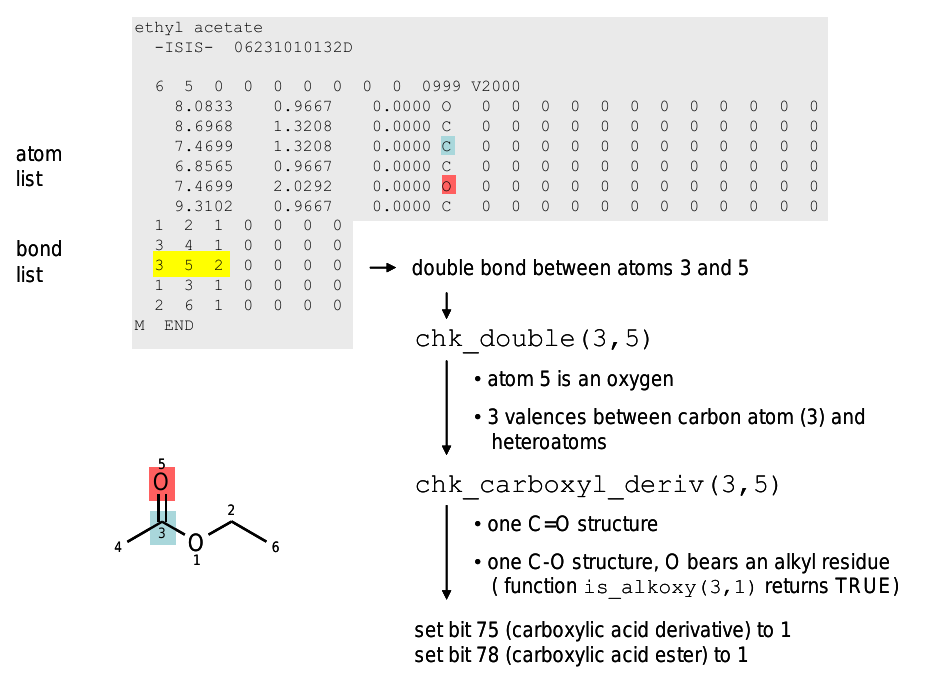
Figure 3. MDL molfile of ethyl acetate, pseudo-code for detection of the ester